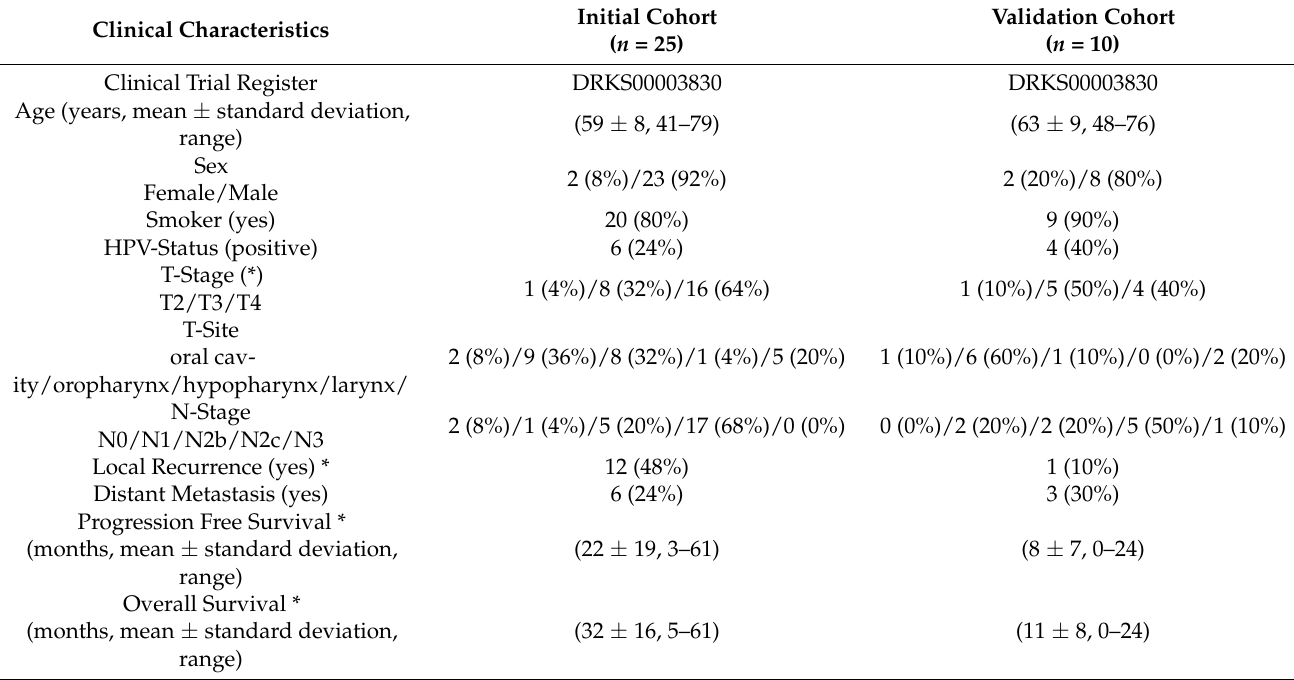
Table 1. Clinical characteristics of the patient